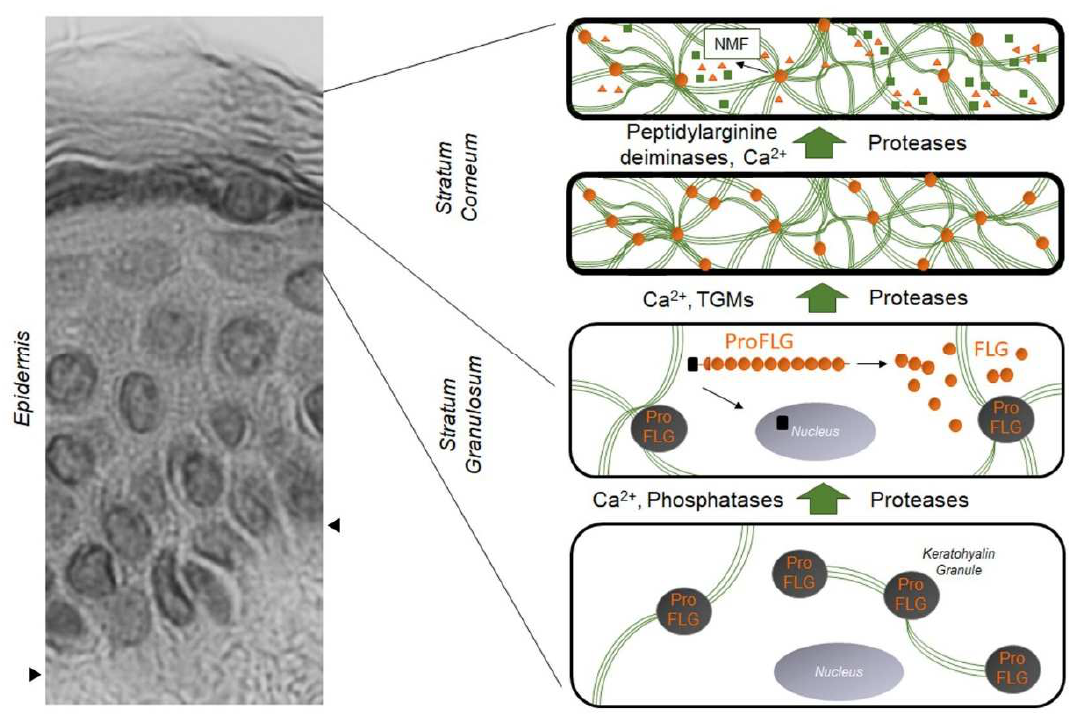
Figure 1. Evolution and distribution of profilaggrin and filaggrin during epidermal differentiation: dark gray disks con- taining profilaggrin are keratohyalin granules present in the cytoplasm of granular KCs. Under the action of phosphatases, proteases, and Ca 2+ , profilaggrin is expelled in the cytoplasm and degraded into filaggrin monomers (small orange disks). Green lines are keratin filaments aggregated by filaggrin monomers in the lower SC. Under the action of transglutaminases (TGMs), filaggrin molecules may be covalently linked to the cornified envelope. In the upper SC, filaggrin is further pro- cessed into free amino acids by the sequential action of peptidylarginine deaminases and proteases, producing the Natural Moisturizing Factor (NMF, green squares and orange triangles). The left part of the figure is a hematoxylin–eosin staining of a healthy human epidermis; arrows show the dermis–epidermis junction.